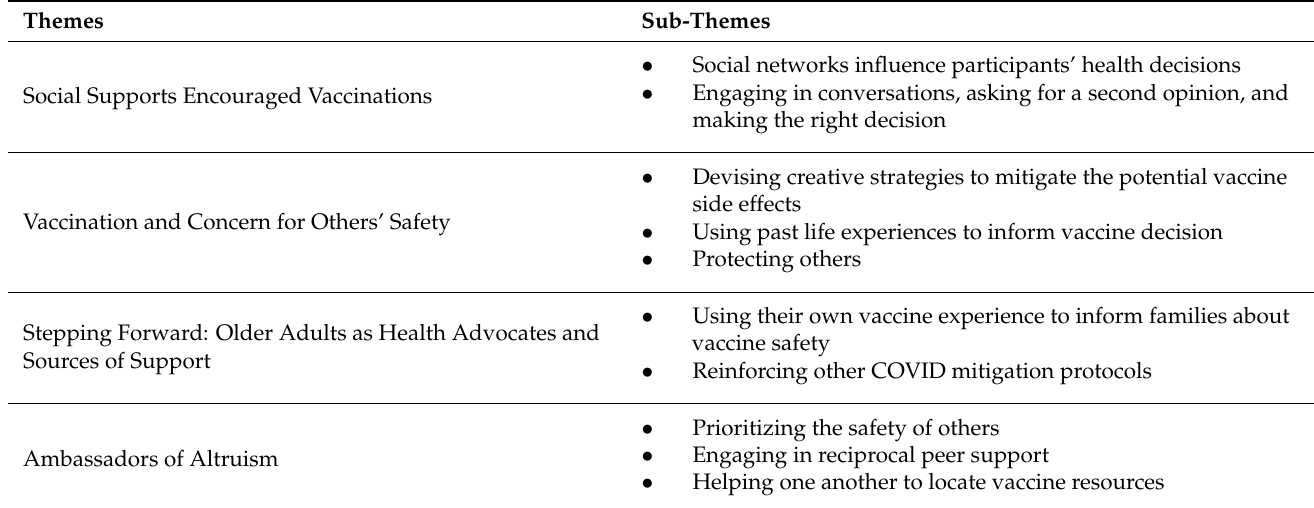
Table 2. Findings’ themes and